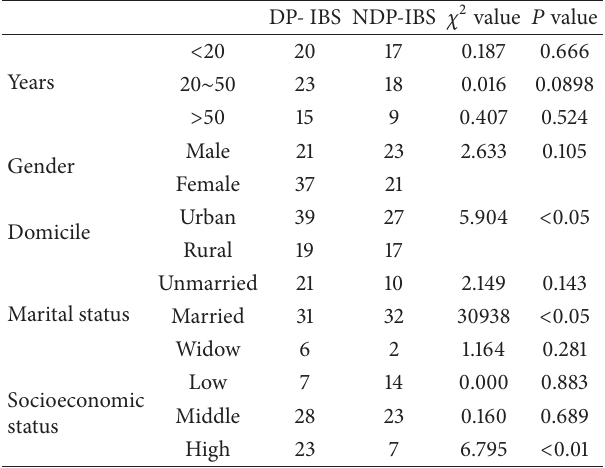
Table 2: Comparison between the baseline characteristics of DP- IBS and NDP-IBS